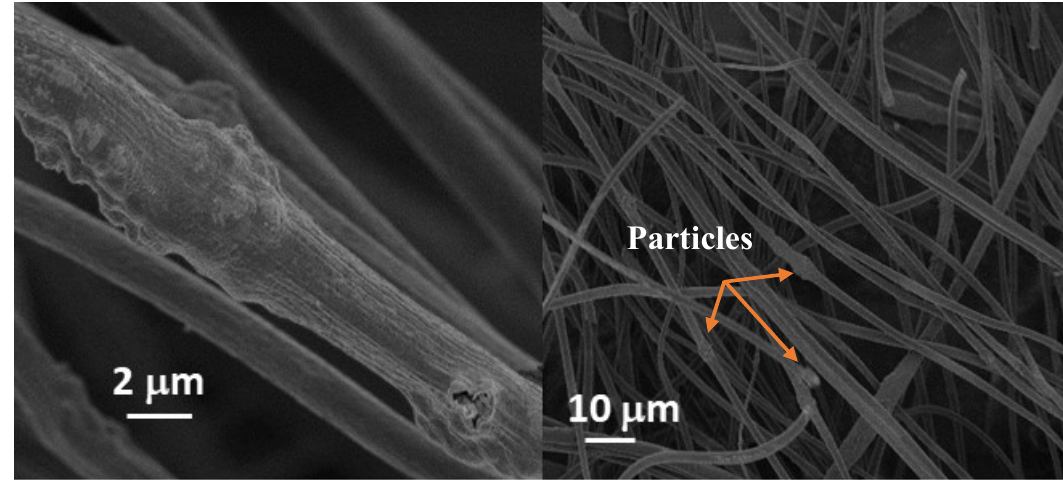
Figure 1. SEM images of a SnO 2 / C composite-fiber membrane [20], with copyright permission from the IOP Publishing.